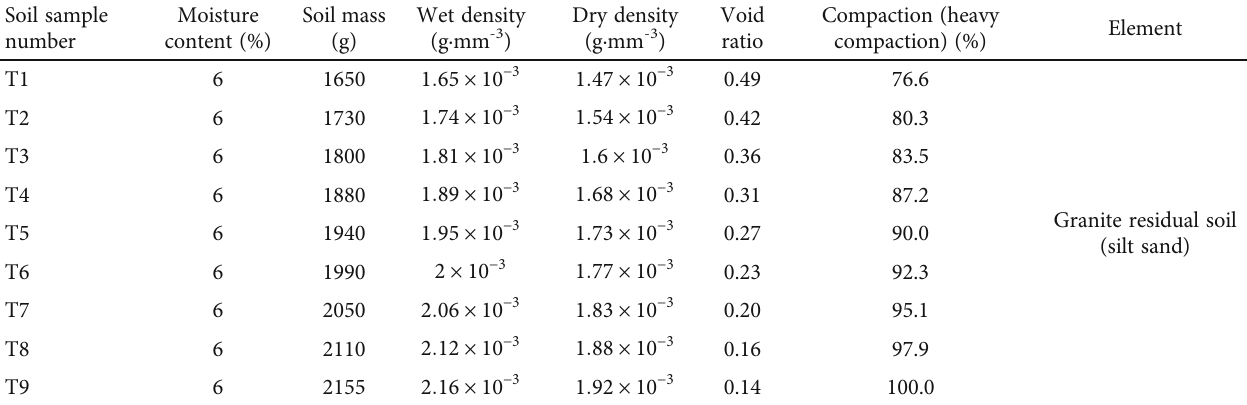
Table 1: Physical parameter and mechanical indexes of soil samples.